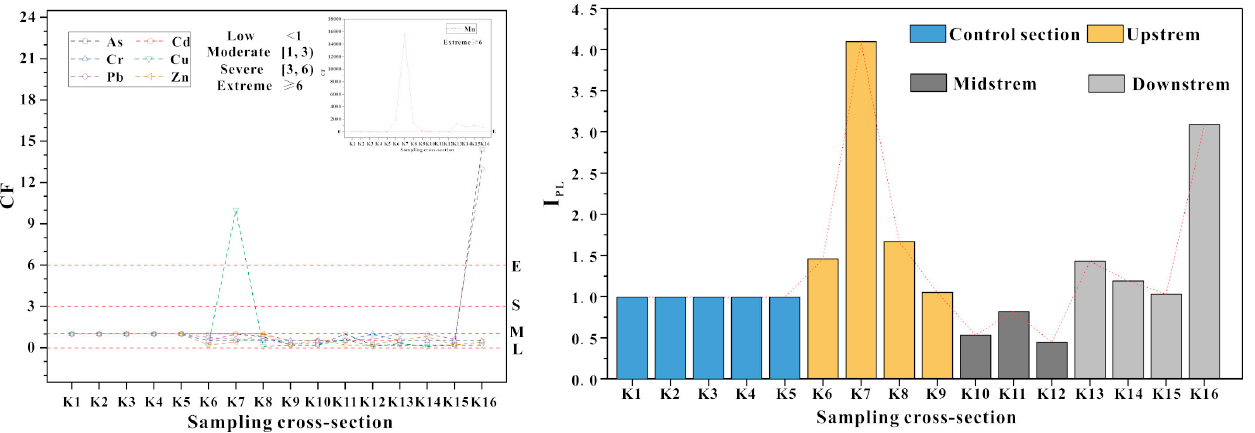
Figure 6. PTE pollution factors (contamination factor (CF) and I PL ) in the river waters and sediments.